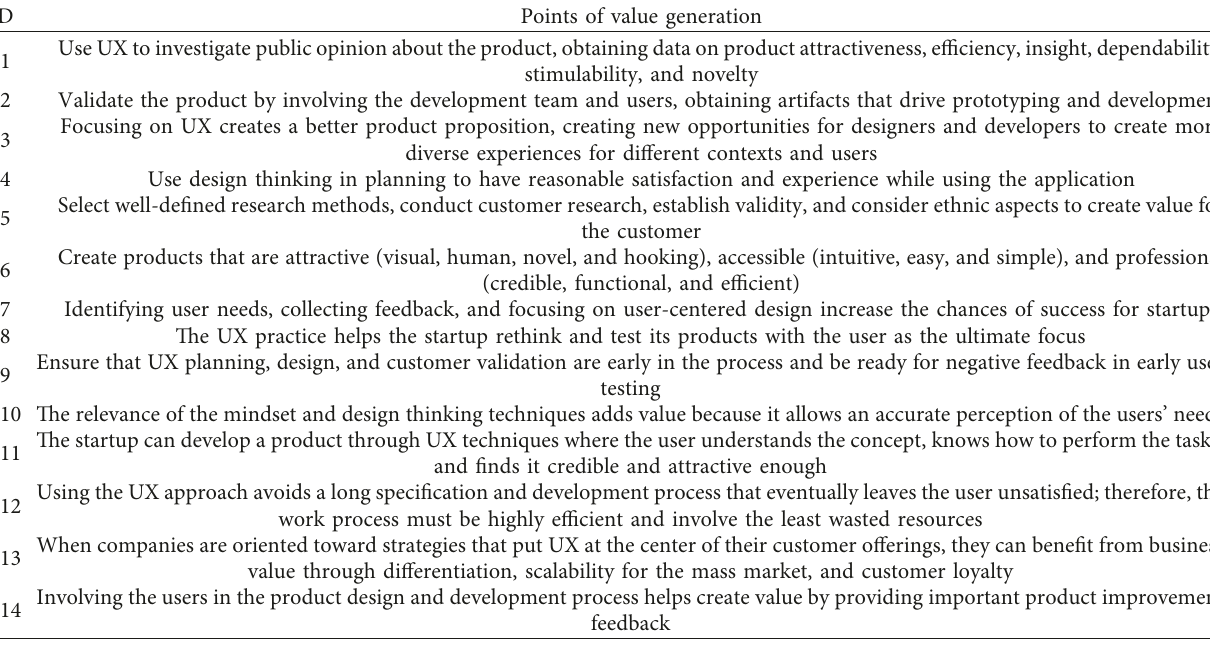
Table 7: Points identified in the papers where UX, products, and services are linked in developing customer